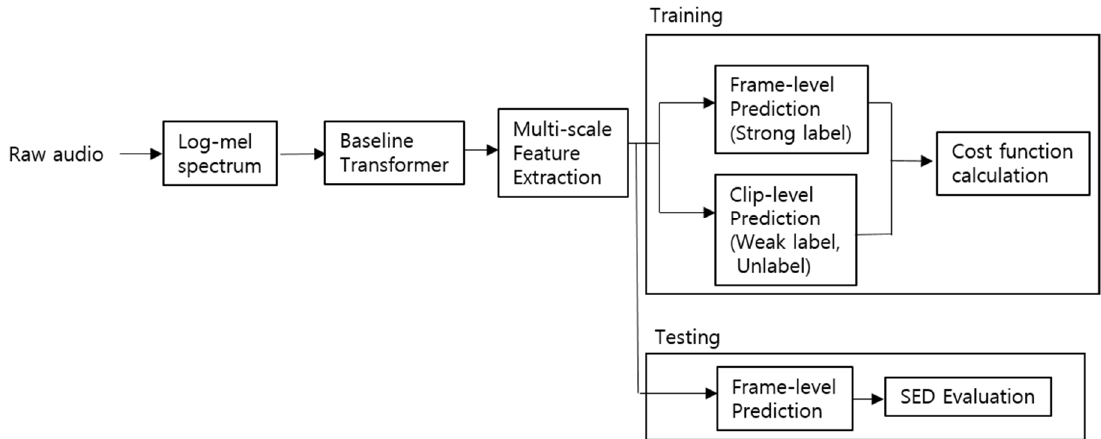
Figure 3. Procedure of the Training and Testing in the Proposed Transformer Network Model.